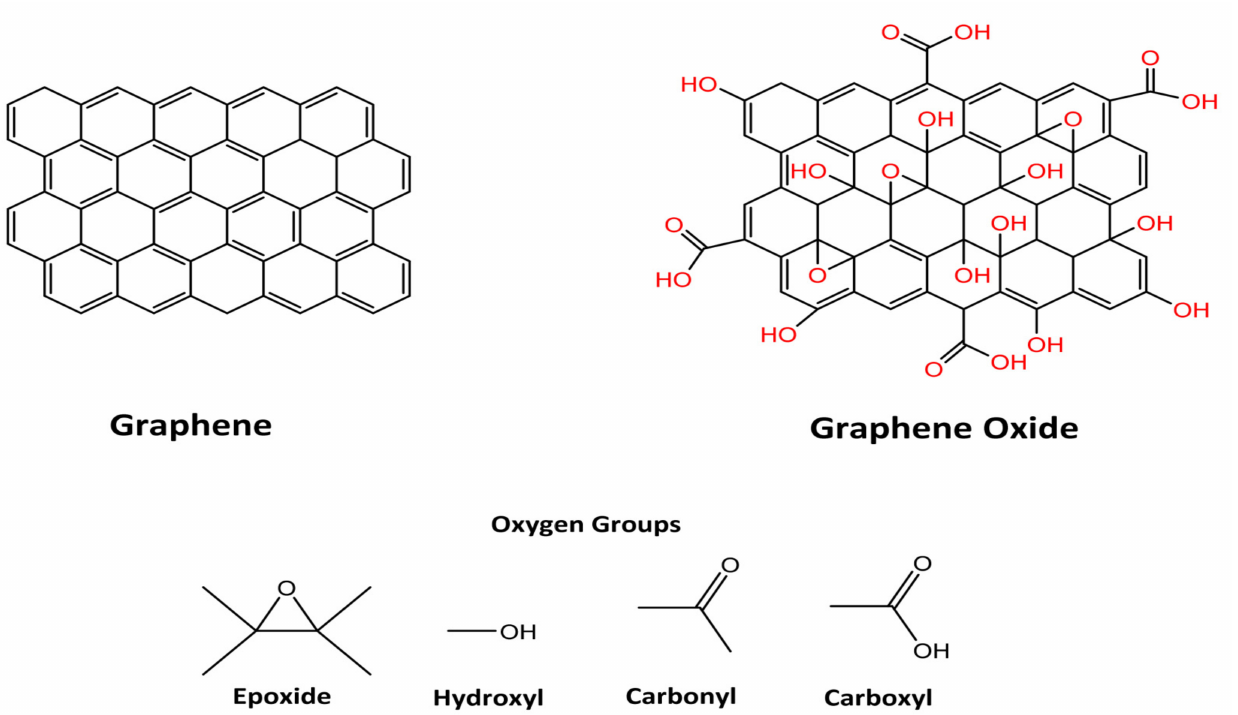
Figure 9. Schematic representation of the graphene and graphene oxide structures and graphene ox- ide oxygenated groups. [Reprinted with permission from ref. [87], Olean-Oliveira, A.; Oliveira Brito, G.A.; Cardoso, C.X.; Teixeira, M.F.S. Nanocomposite Materials Based on Electrochemically Synthe- sized Graphene Polymers: Molecular Architecture Strategies for Sensor Applications. Chemosensors 2021 , 9 , 149. https://doi.org/10.3390/chemosensors9060149, Copyright ©